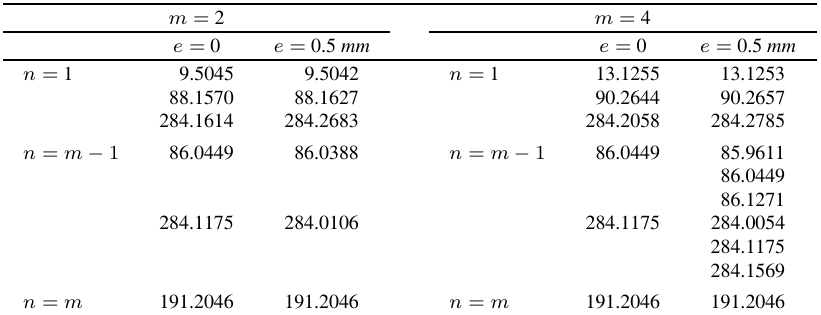
Table 2 Natural frequencies of the drive system with eccentric center worm